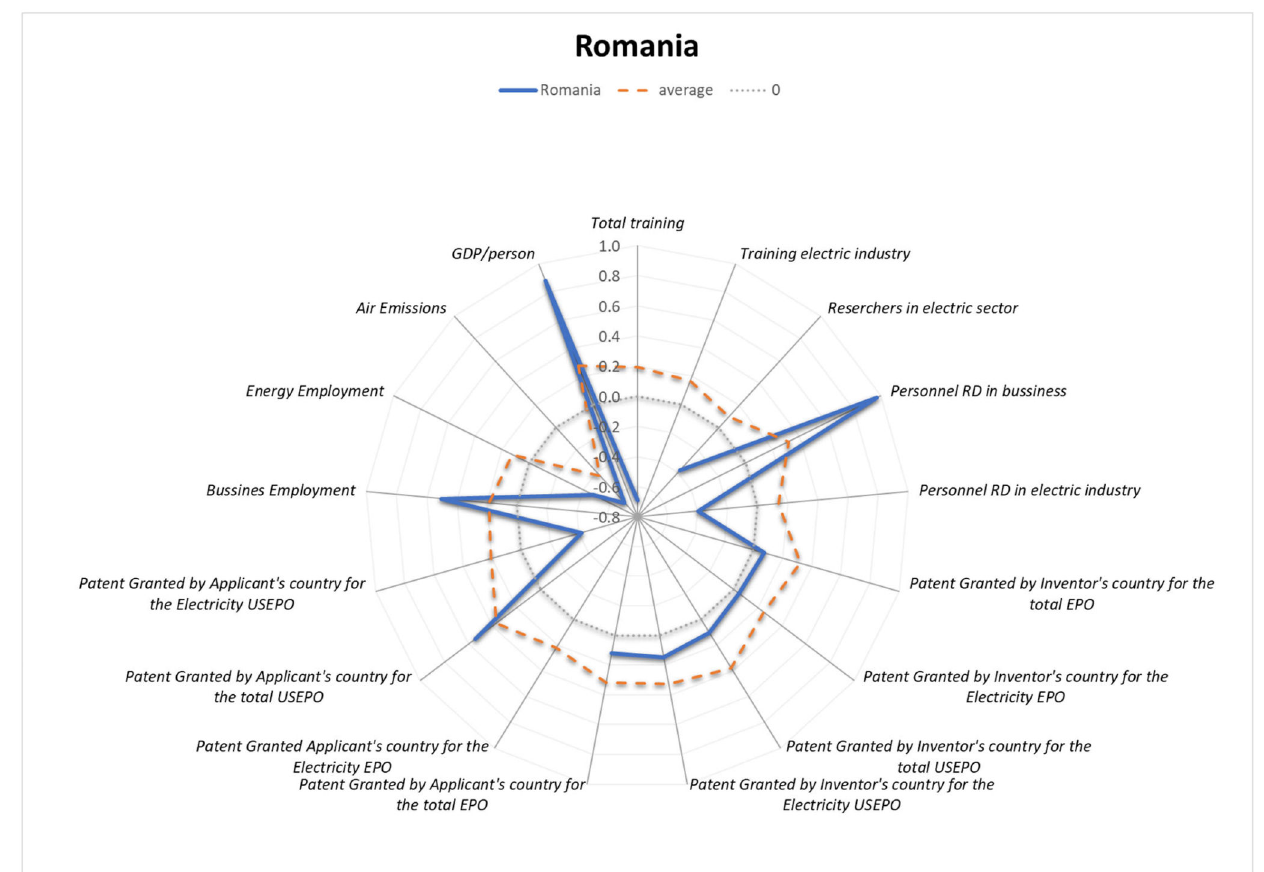
Figure 31. Synergy and trade-off occurrence—RO. Source: Authors’